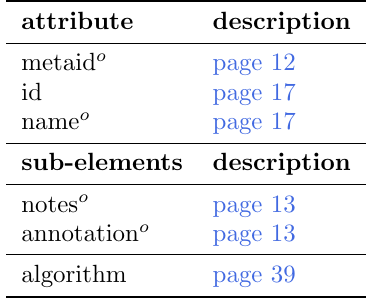
Table 2.16: Attributes and nested elements for steadyState. o denotes optional elements and at- tributes.